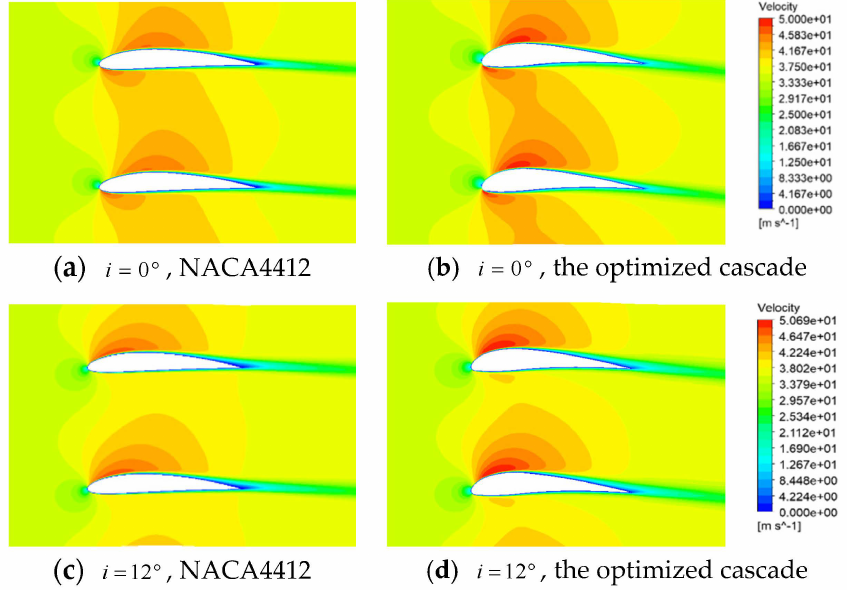
Figure 10. Velocity